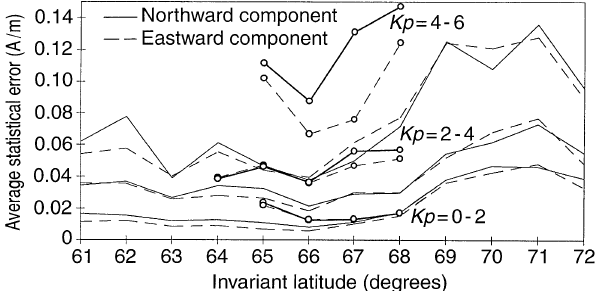
Fig. 3. Latitudinal variation of the 24-h-averaged statistical errors on the northward ( full lines ) and eastward ( dashed lines ) current components for the three magnetic-activity ranges. Continuous lines refer to currents derived with conductance models and lines with open circles with observed